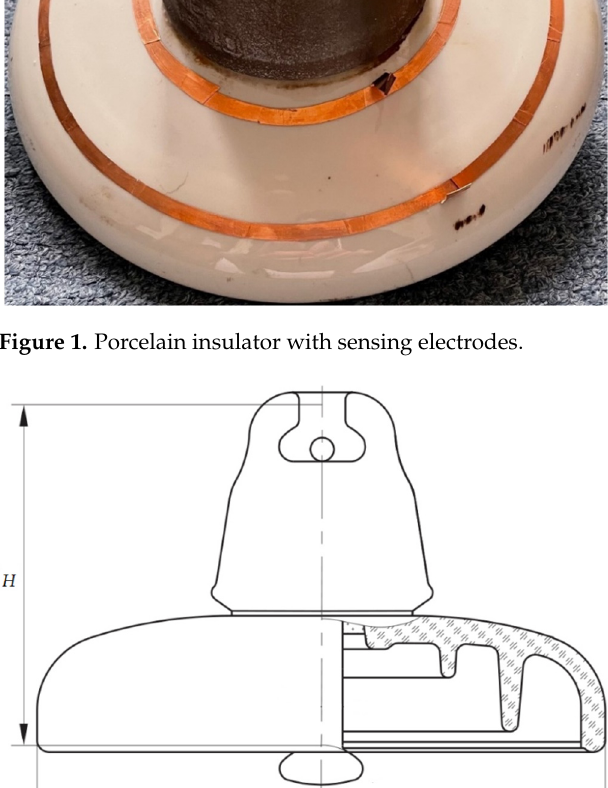
Figure 1. Porcelain insulator with sensing electrodes.